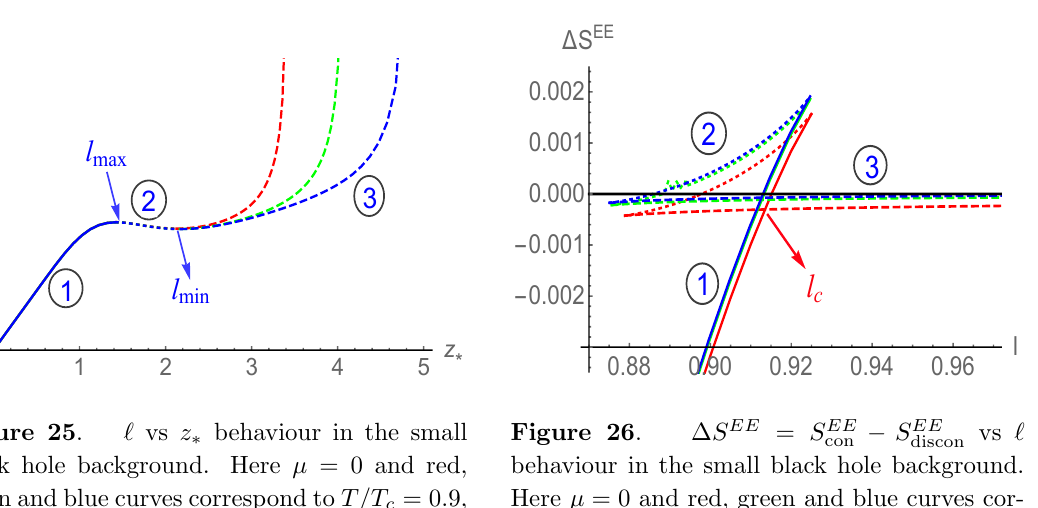
Figure 25 . ‘ vs z (cid:3) behaviour in the small black hole background. Here (cid:22) = 0 and red, green and blue curves correspond to T=T c = 0 : 9, 0 : 8 and 0 : 7 respectively. In units GeV.